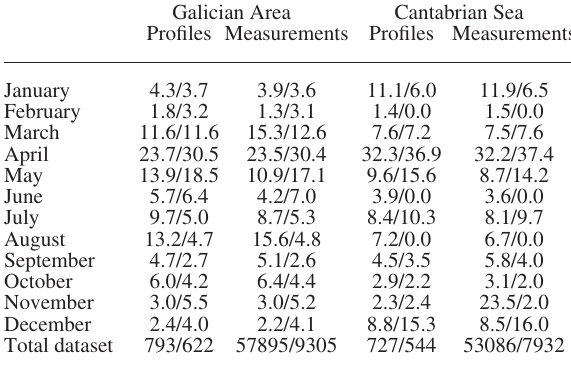
Table 1. – Monthly distribution of number of profiles and measure- ments (normalised by the total data set shown in the bottom row) in the interior ocean/continental shelf within the Galician Area and Cantabrian Sea. Galician Area Cantabrian Sea Profiles Measurements Profiles Measurements